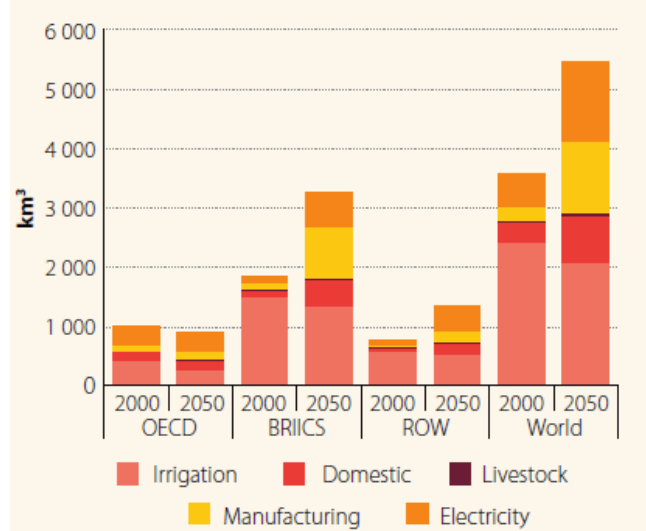
Fig. 1 Global water demand (freshwater withdrawals): Baseline scenario, 2000 and 2050. Note: BRIICS: Brazil, Russia, India, Indonesia, China, South Africa; OECD: Organisation for Economic Co- operation and Development; ROW: rest of the world. This graph only measures ‘blue water’ demand and does not consider rainfed agriculture. Source: WWAP 2014 (Fig. 2.1, p.